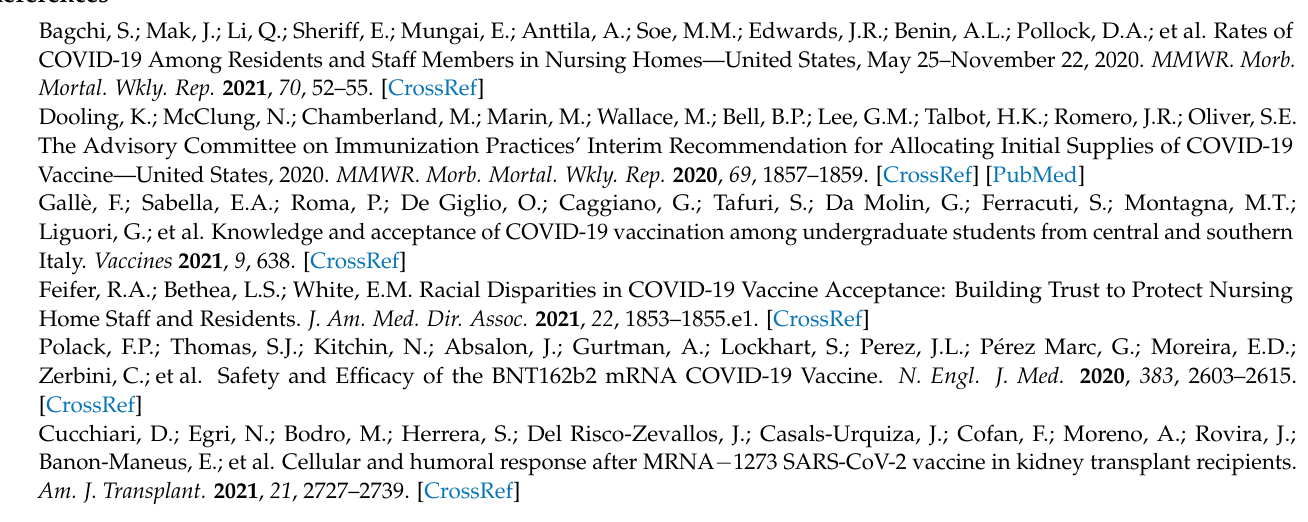
Table S2: Demographic and clinical records of the non-S1 antibodies subjects after 6 months after full